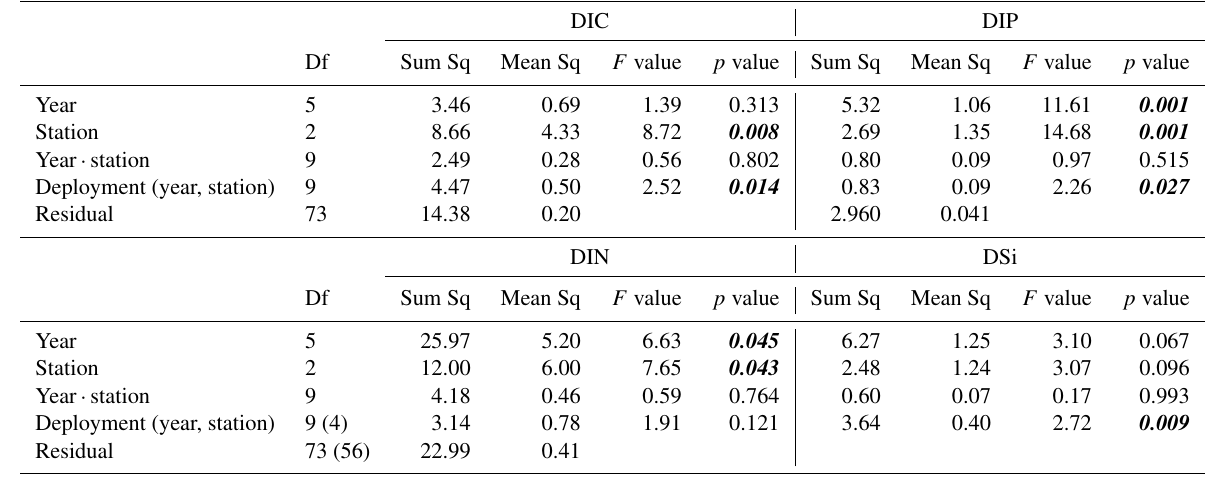
Table A2. Results from the type III ANOVA of sediment–water solute fluxes. Degrees of freedom (df) values for DIN within are given brackets. p values < 0.05 marked in bold and italic font.